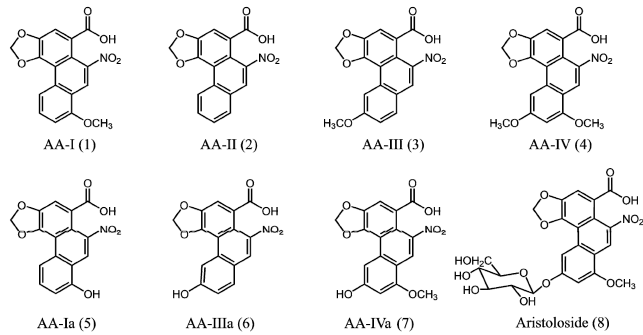
Figure 1. Aristolochic acids in Aristolochia chilensis .